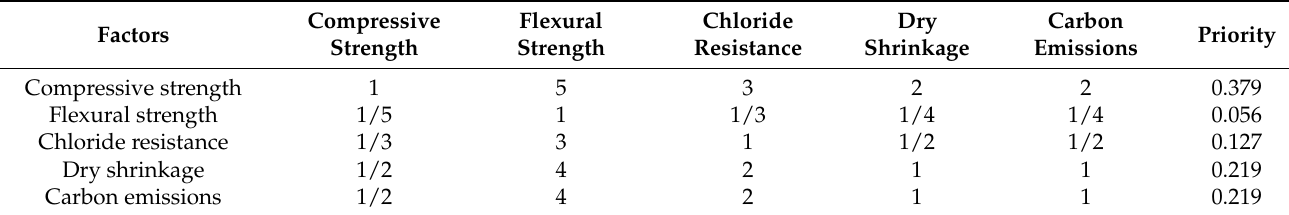
Table 6. Priority of different